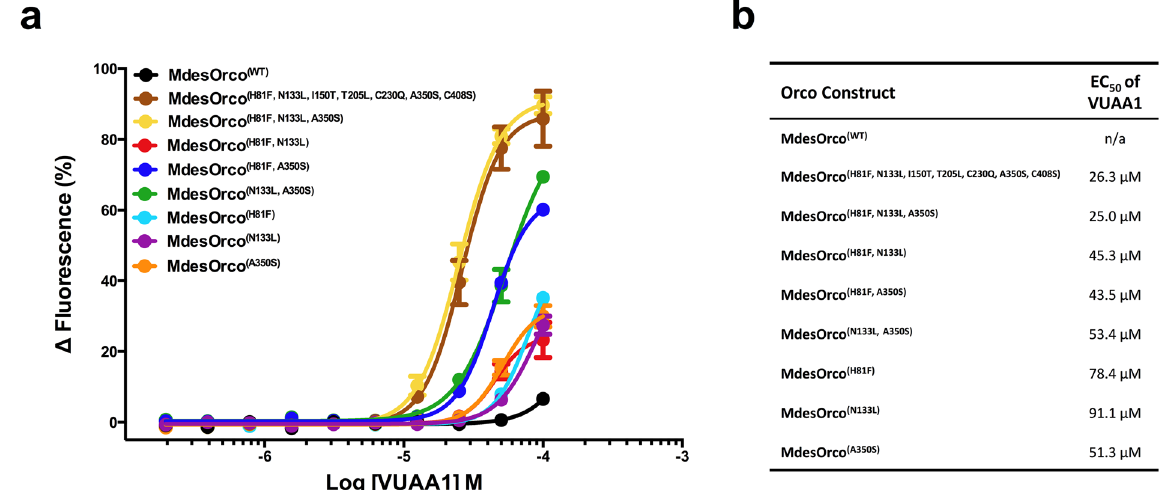
Figure 2. ( a) Response of TREx/HEK293 cells expressing wild-type or various mutated forms of MdesOrco to different concentrations of the Orco agonist VUAA1. ( b) EC 50 values for the responses shown in ( a ). Data represent the mean response ( ± SEM) of cells from three biological replicates. Note: all data points contain error bars; some are too small to be seen.